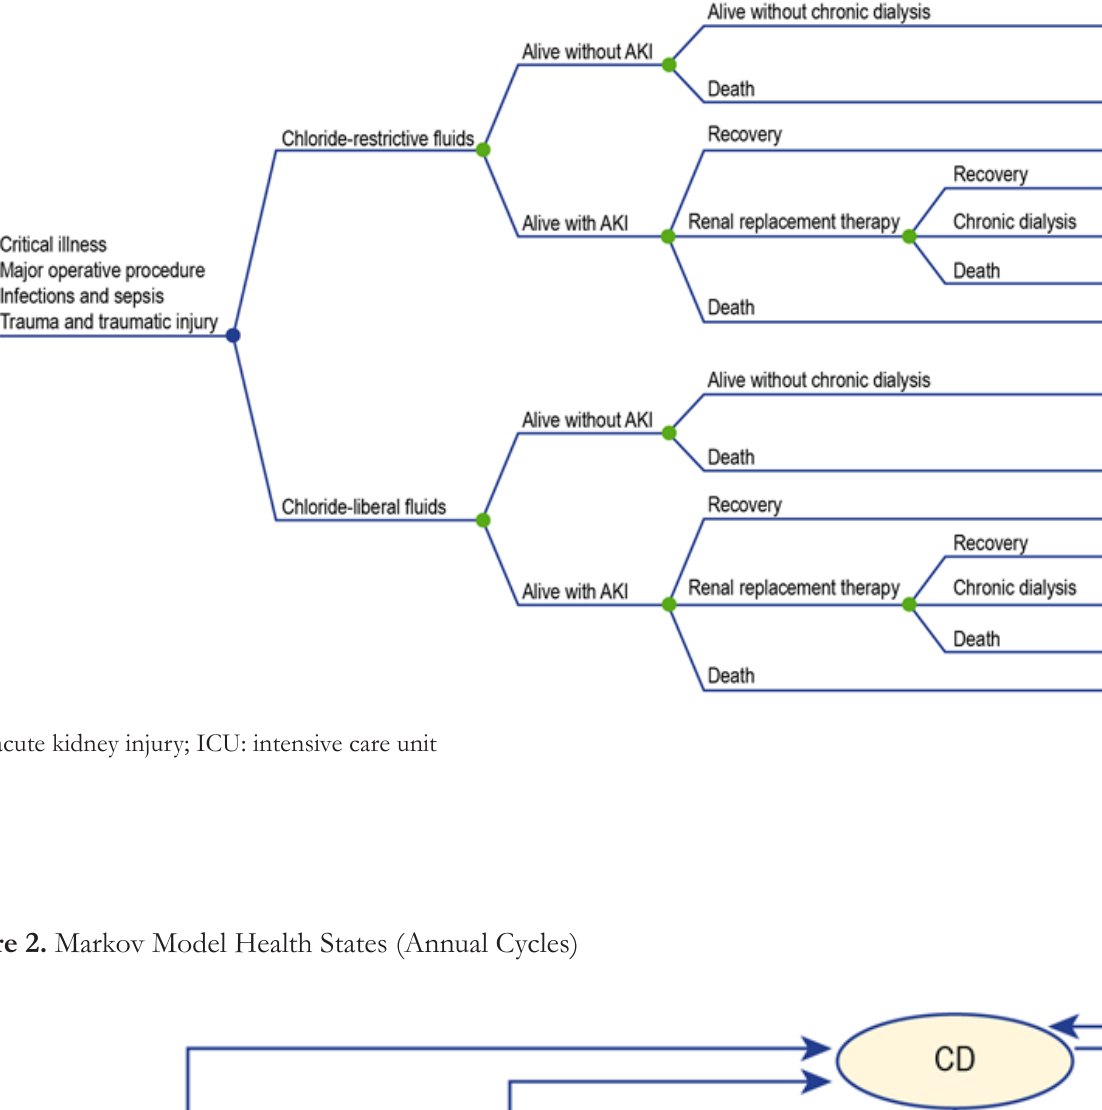
Figure 1. Decision Tree Structure (90-day Period Following ICU Admission)